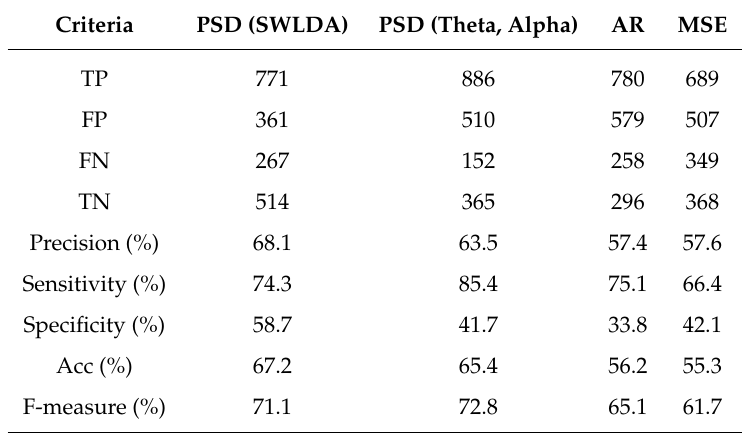
Table 3. Performance summary of alert vs. drowsy classifications when the thresholds for the two classes were set to 4 and 6.